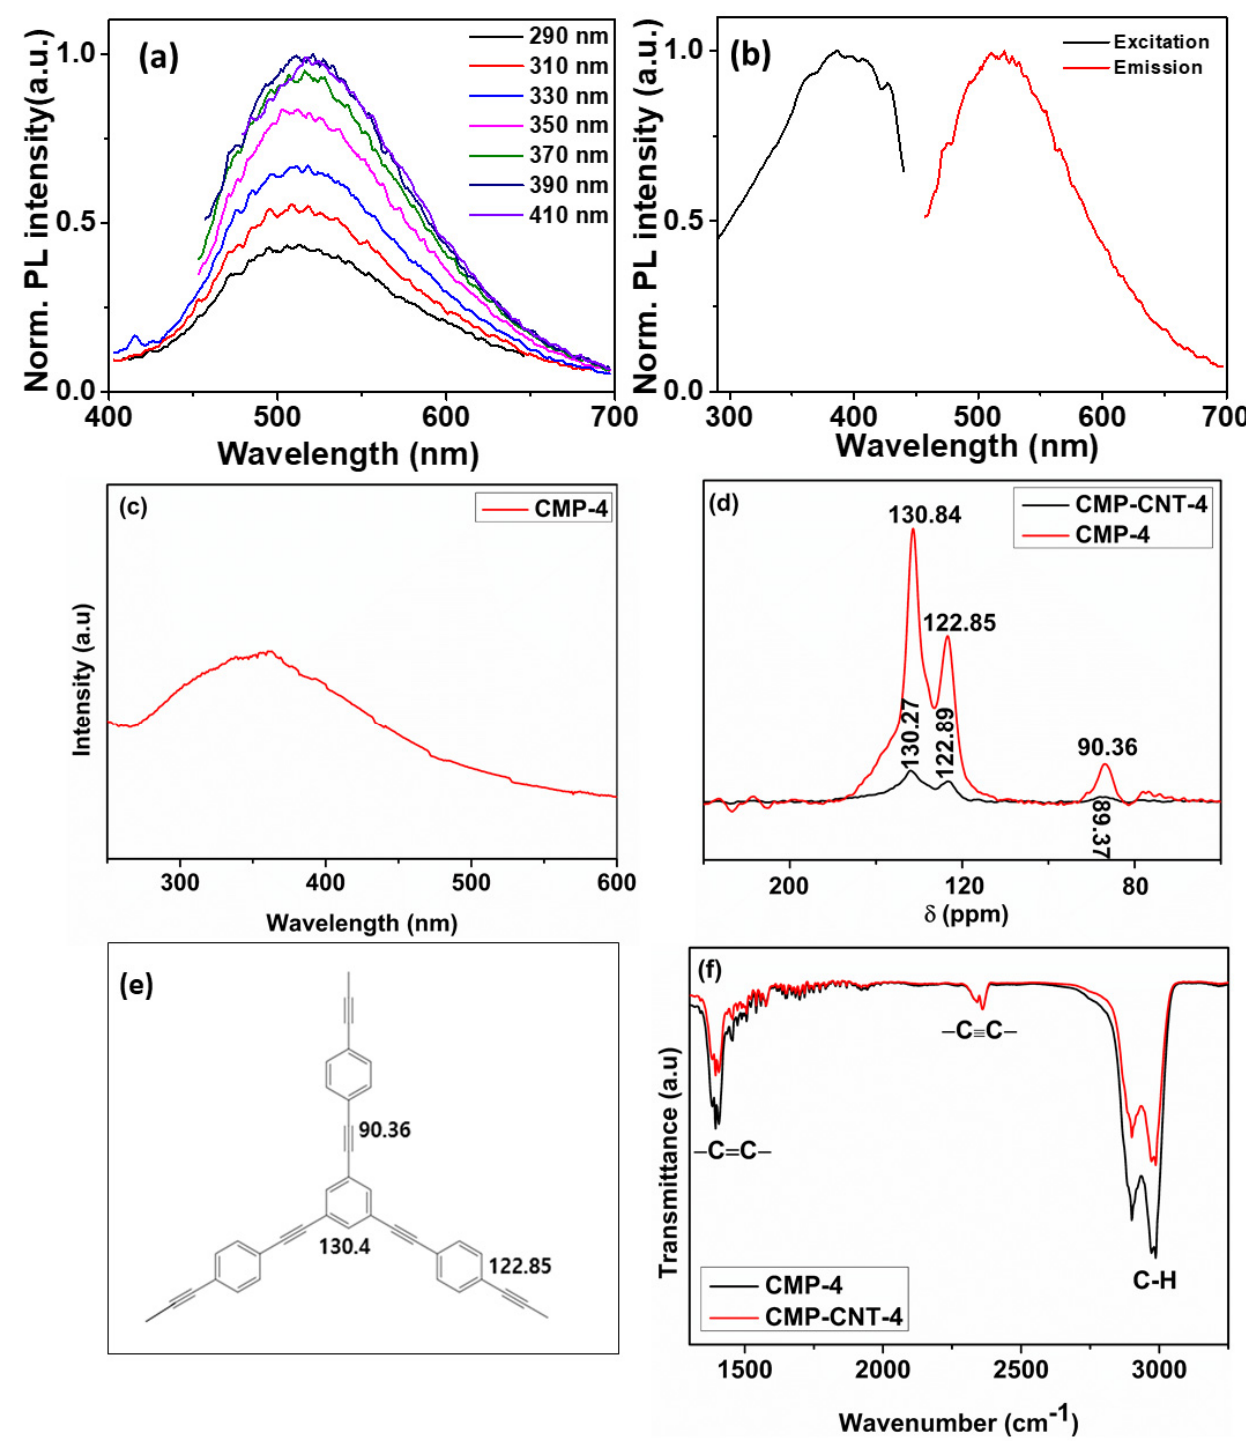
Figure 1. ( a ) Wavelength-depended fluorescence emission spectra of CMP-4; ( b ) excitation and emission maximum spectra of CMP-4; ( c ) UV–Vis spectra of CMP-4; ( d ) solid-state C 13 NMR spectra of CMP-4 and CMP-CNT-4; ( e ) structure and 13 C NMR value for CMP-4 and the orientation of π electrons. ( f ) FT-IR spectrum of CMP-4 and CMP ‐ CNT ‐ 4.